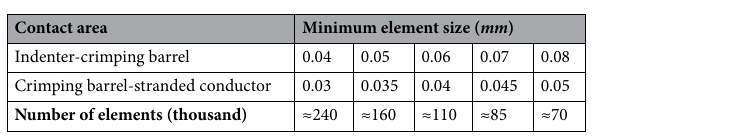
Table 3. The number of elements corresponding to different mesh refinement densities.